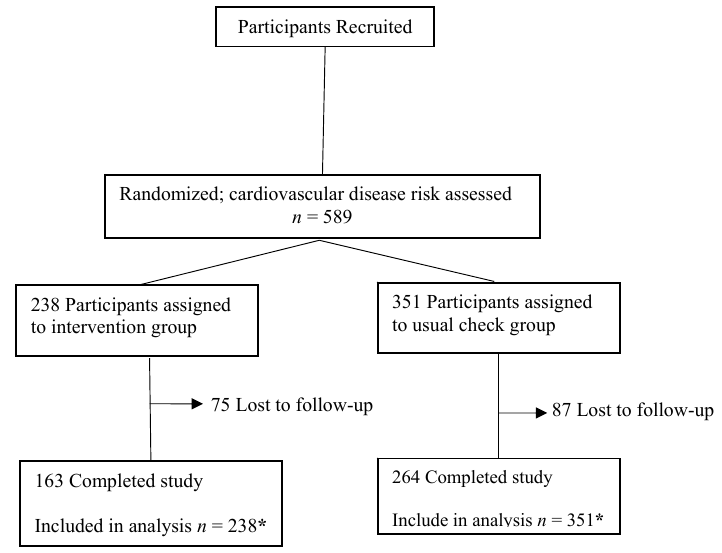
Figure 1. Study design and participant flow. * Data were imputed for the participants lost to follow-up.